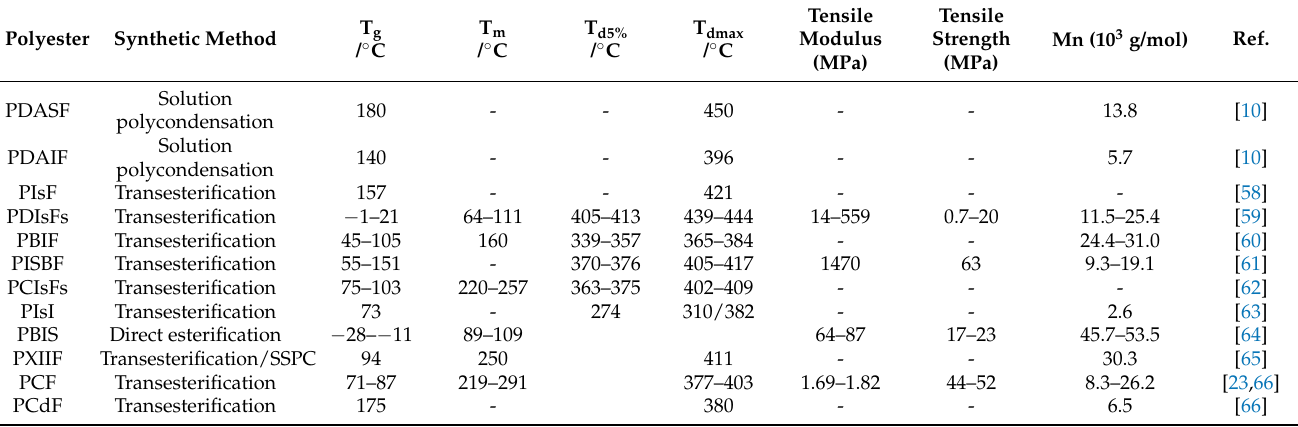
Table 2. Thermal and mechanical properties of furan-polyesters with rigid diols via different synthetic